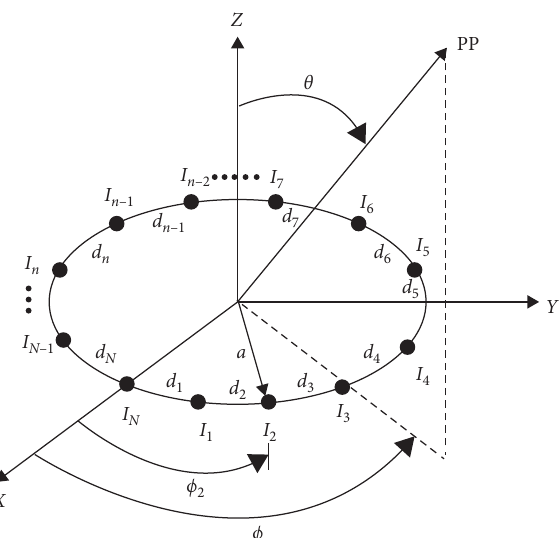
Figure 2: Geometry of a nonuniform